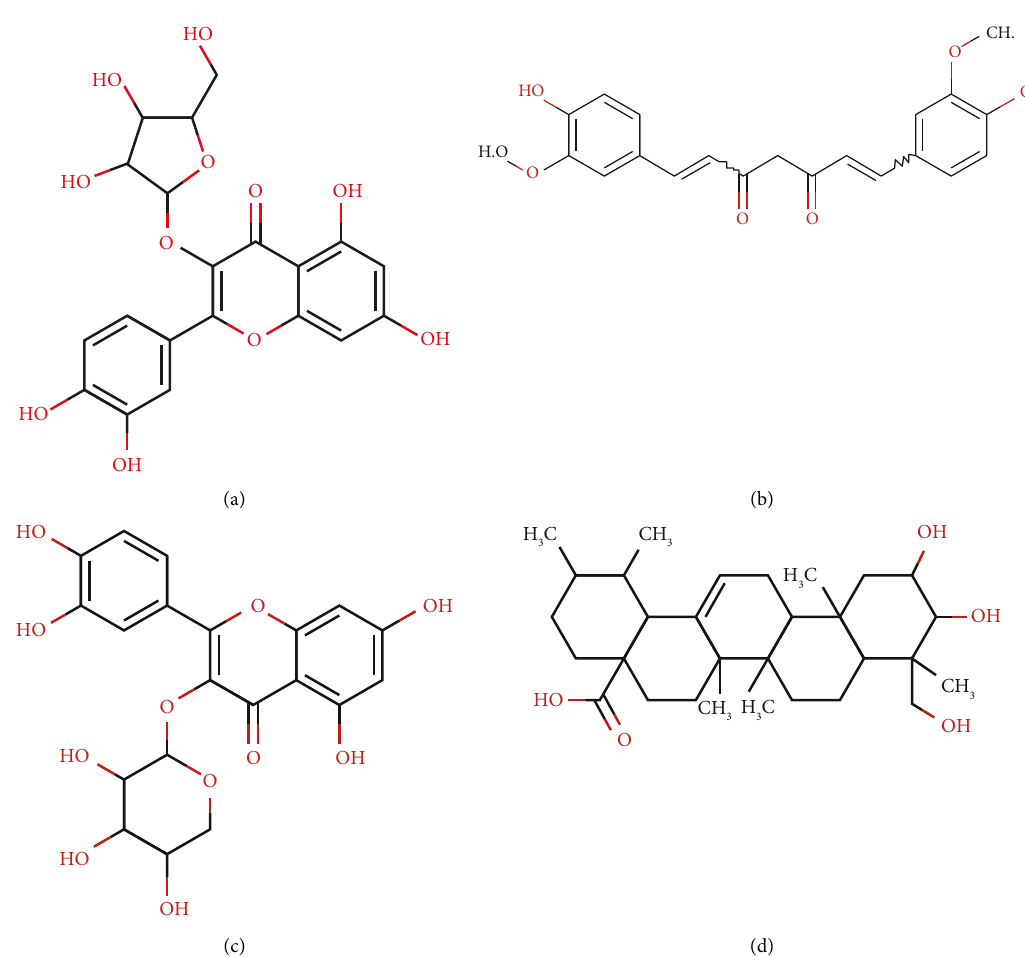
Figure 4: Chemical structures of selected metabolites (a) avicularin, (b) Asiatic acid, (c) curcumin, and (d)